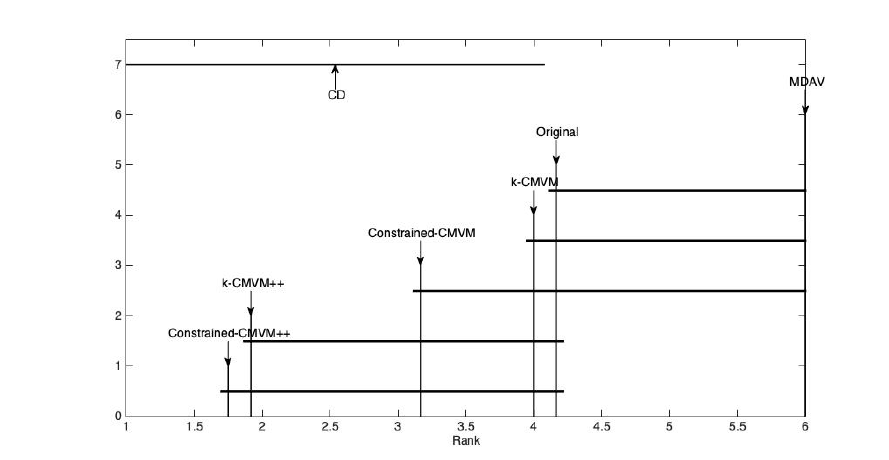
Figure 1: Friedman and Nemenyi test for comparing multiple approaches over multiple data sets: Approaches are ordered from left (the best) to right (the